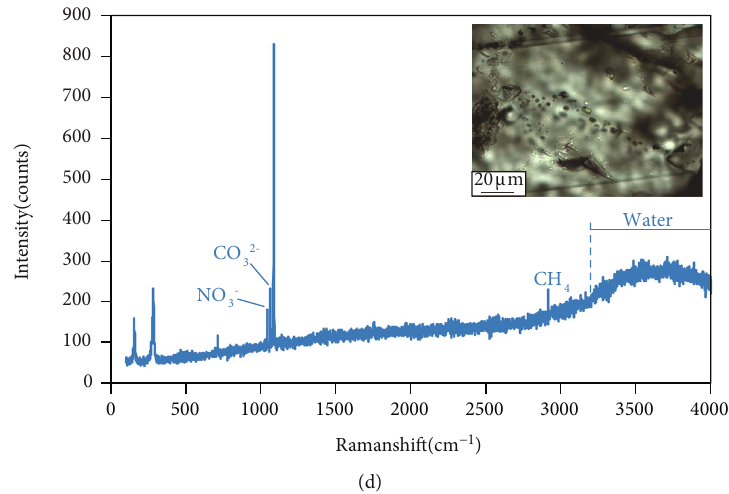
Figure 8: Raman spectra of fl uid inclusions in the J